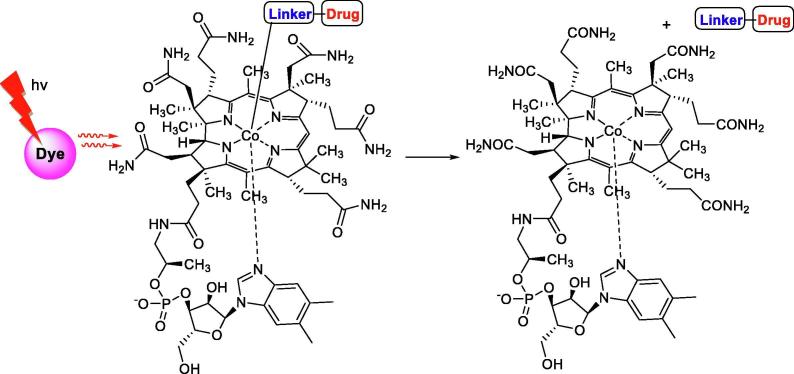
Analogs of vitamin B12 as “caging” groups [20], [21].